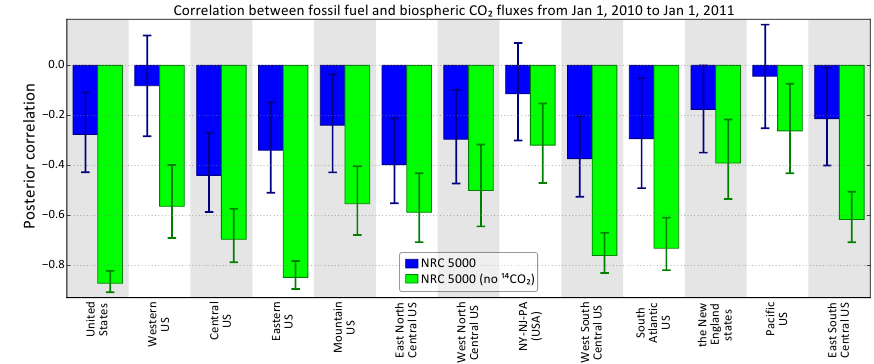
Figure 9. Posterior correlation between fossil fuel and biospheric CO 2 fluxes obtained with and without 14 CO 2 measurements for the NRC 5000 network